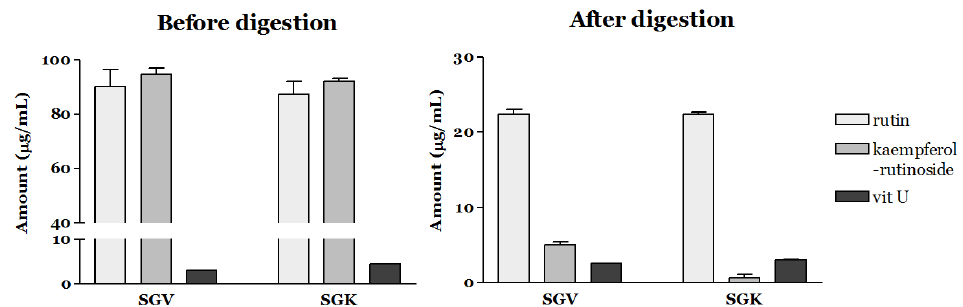
Figure 2. Bioaccessibility of rutin, kaempferol-rutinoside, and vit U from SGV (steamed extract of graviola leaves) and SGK (SGV enriched with kale extract) after simulated gastrointestinal digestion.